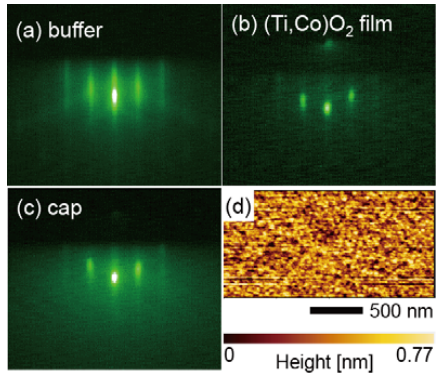
Figure 1. Reflection high energy electron diffraction (RHEED) patterns of ( a ) the buffer layer; ( b ) the (Ti,Co)O 2 film; ( c ) the capping layer. ( d ) Typical topographic image of the sample surface.